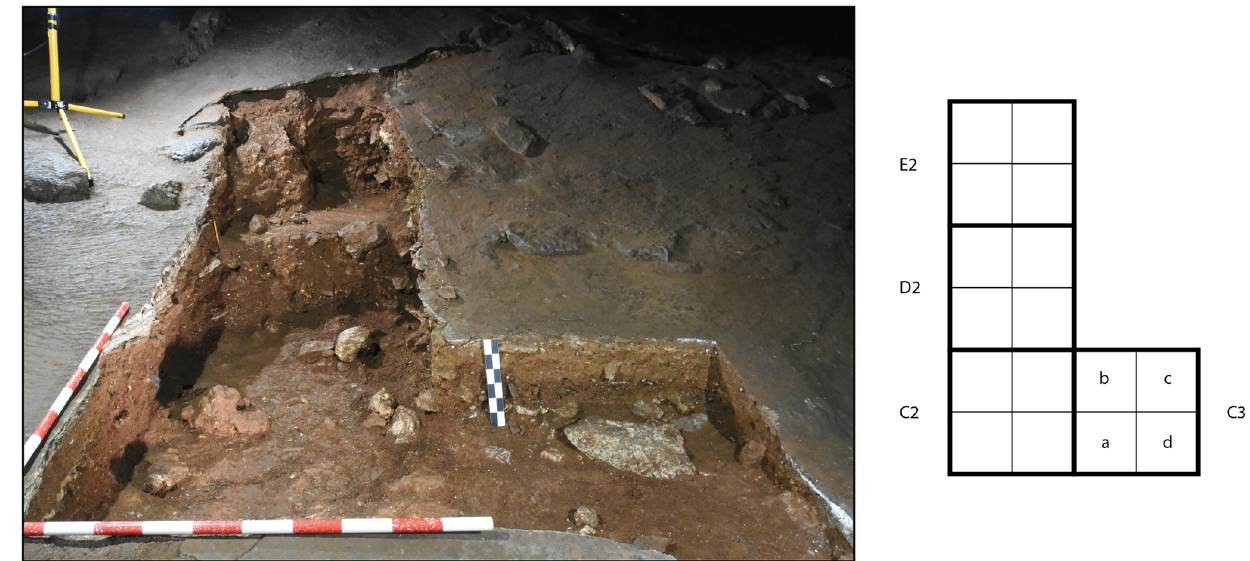
Fig 12. Post-excavation view of zone 3. The plan shows the arrangement of the excavation